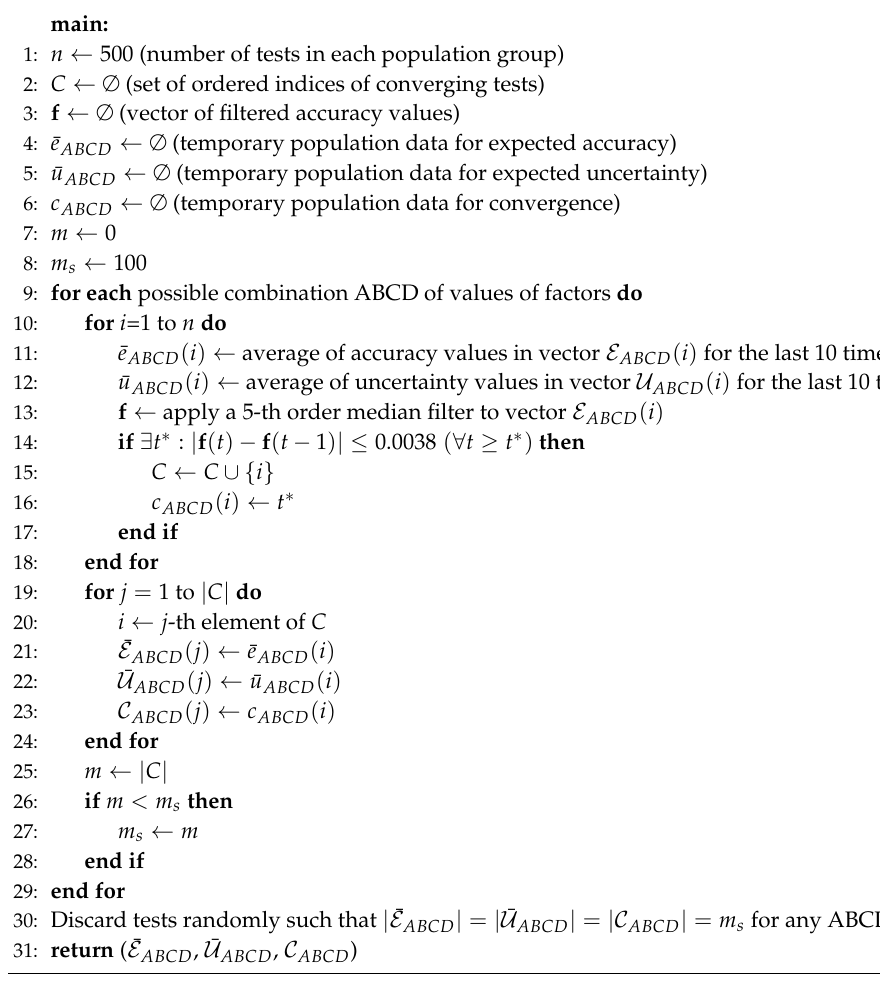
Algorithms A5. performanceData( E ABCD , U ABCD